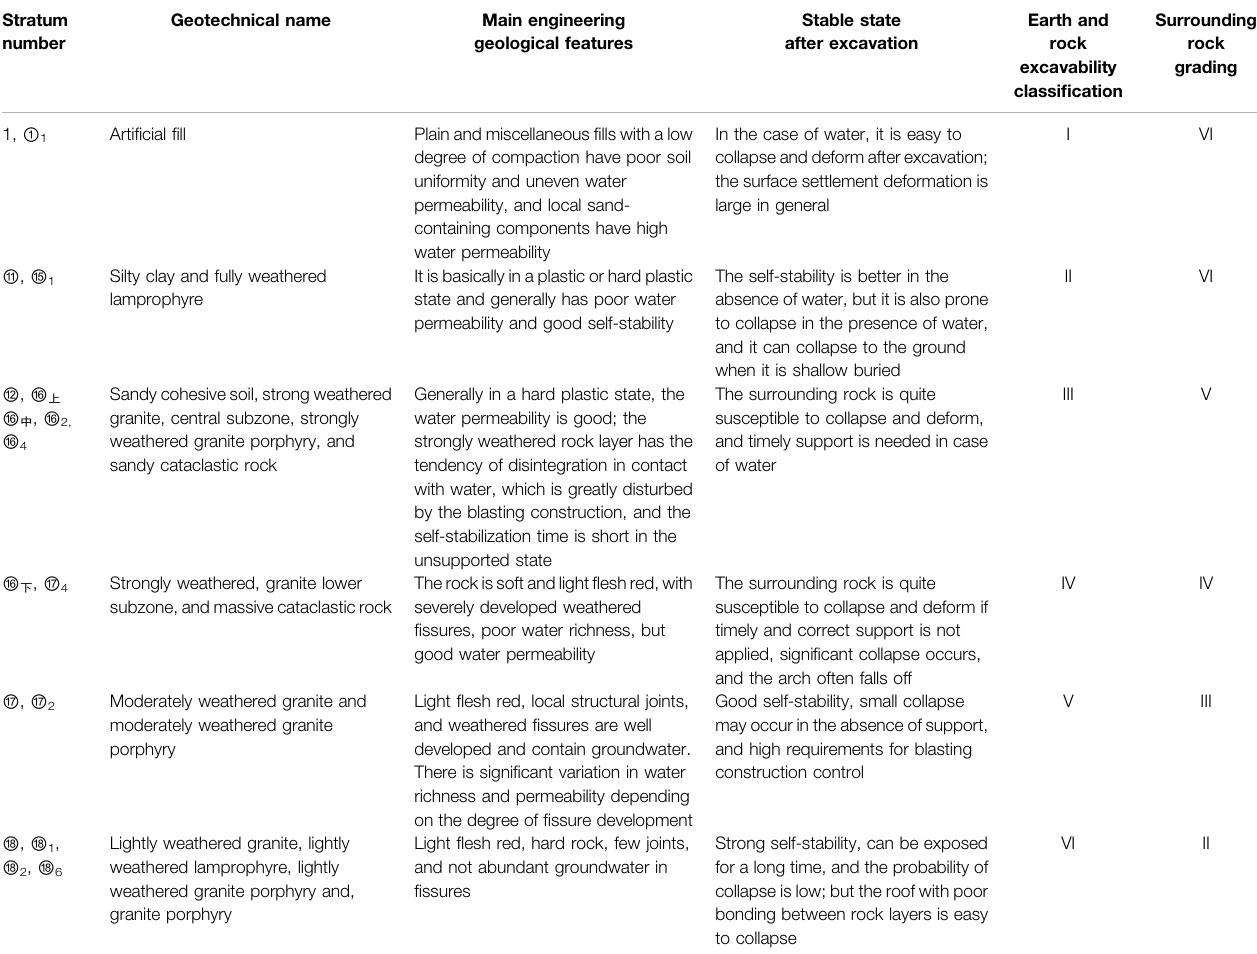
TABLE 1 | Engineering geological parameters of the test